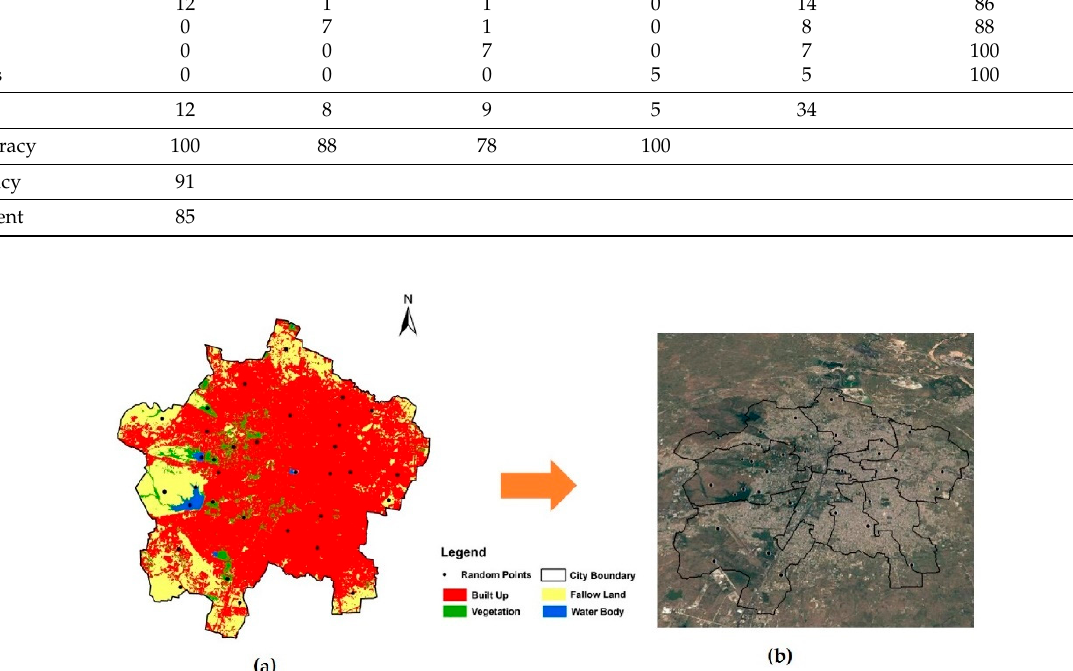
Figure A2. LULC-2020 accuracy assessment random points image in ( a ) GIS ( b ) Google Earth. Table A2 . Accuracy assessment of LULC-2020